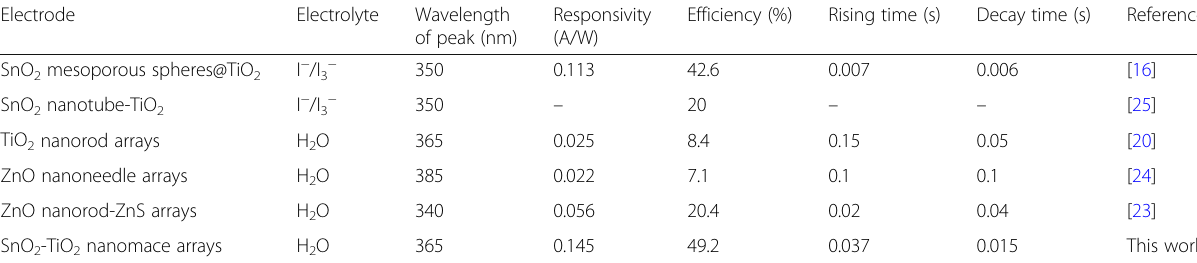
Table 1 Comparison of the self-powered UVPDs with other works Electrode